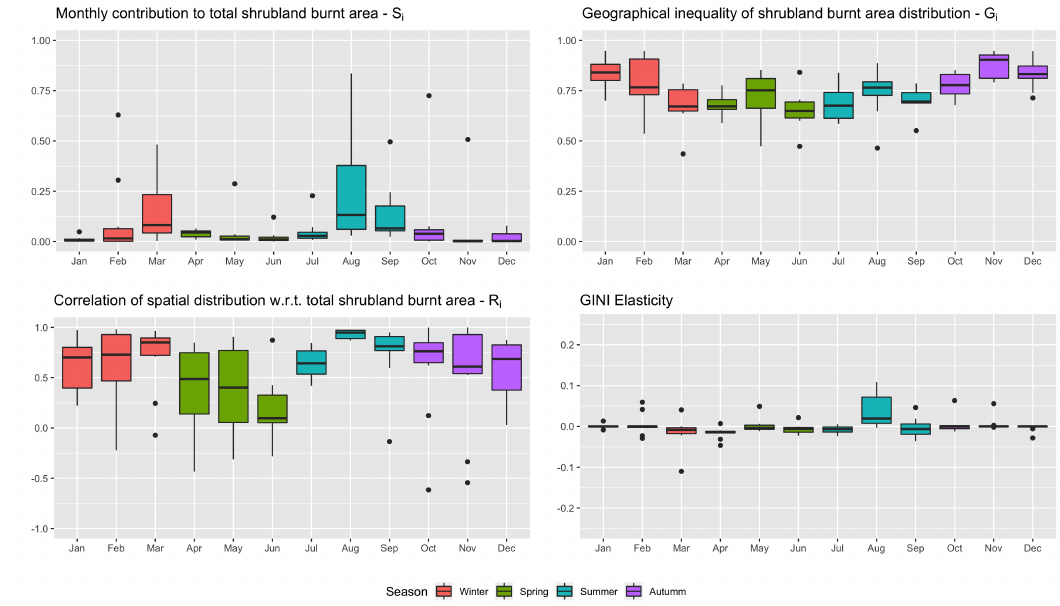
Figure 7. Spatial Gini decomposition of burned shrubland area per month.